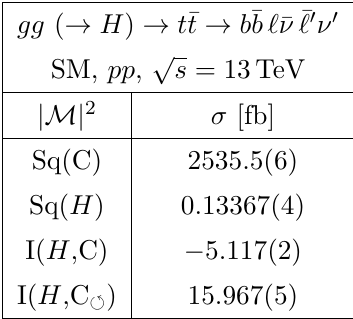
Table 10 . Cross sections for gg ( in the 1-Higgs-Singlet Extension of the SM with M h and mixing angles (cid:18) 1 and (cid:18) 2 (see table 1). Other details as in table 9.